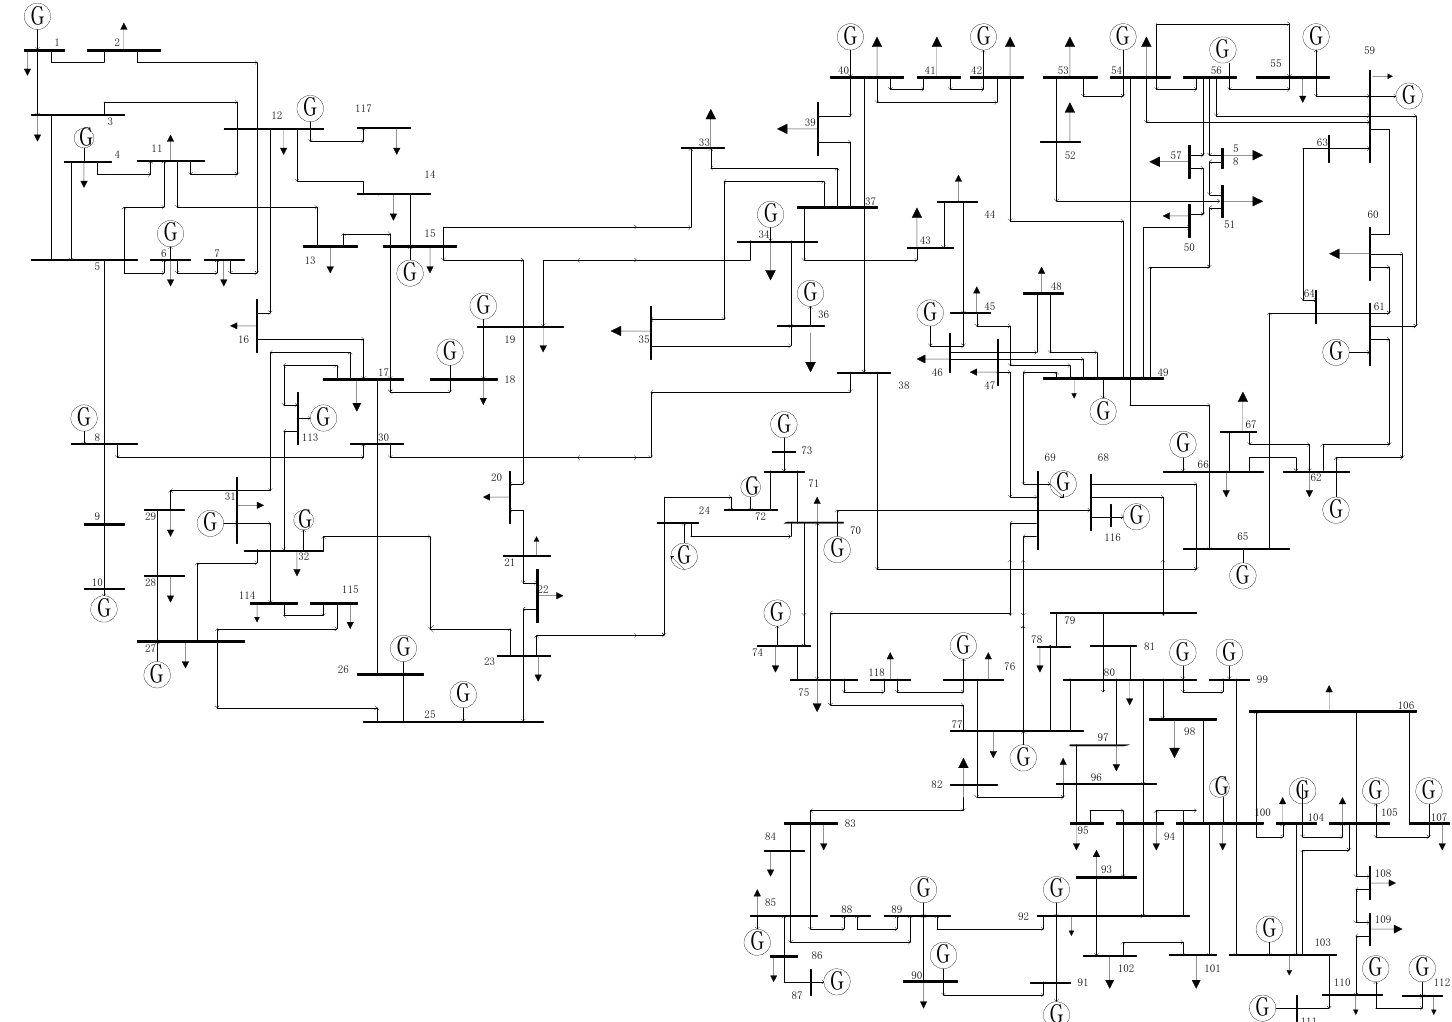
Figure 3. IEEE 118-bus Test